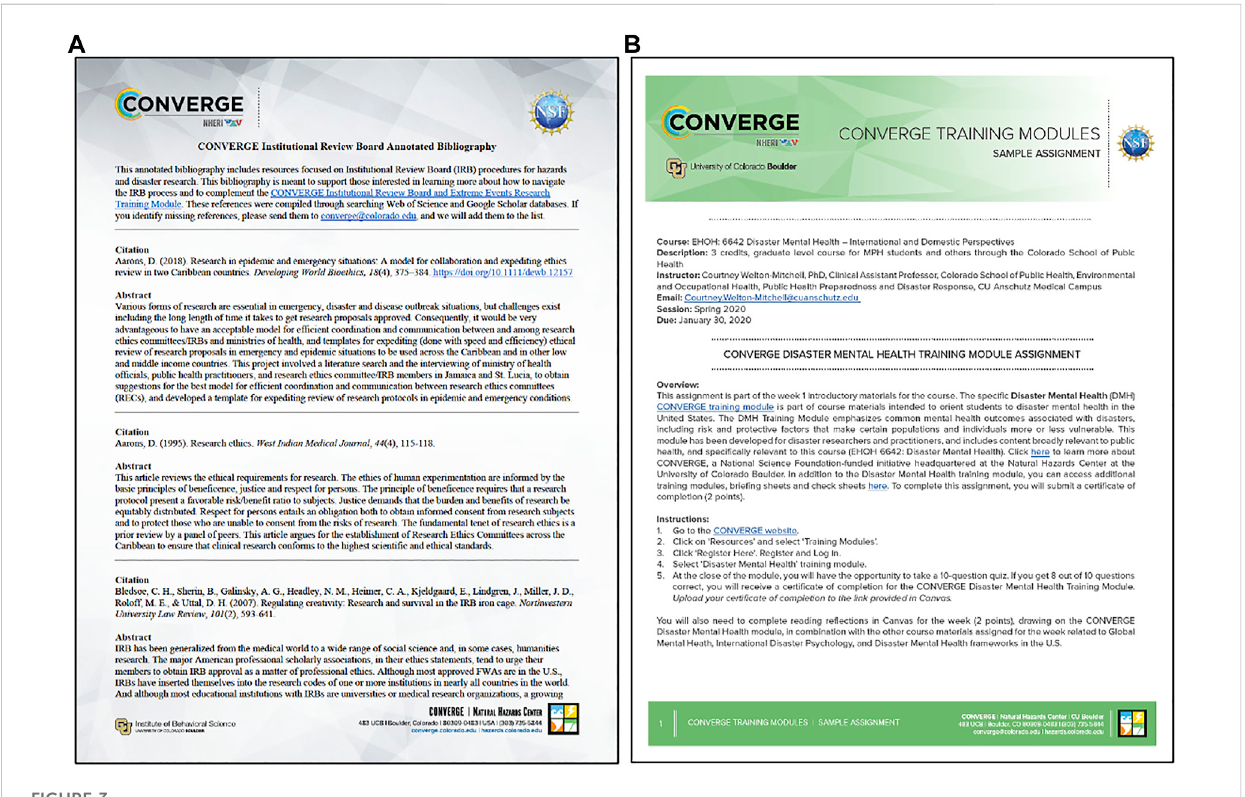
FIGURE 3 The CONVERGE Training Modules Series includes supplementary materials such as Annotated Bibliographies (A) and Sample Classroom Assignments (B)